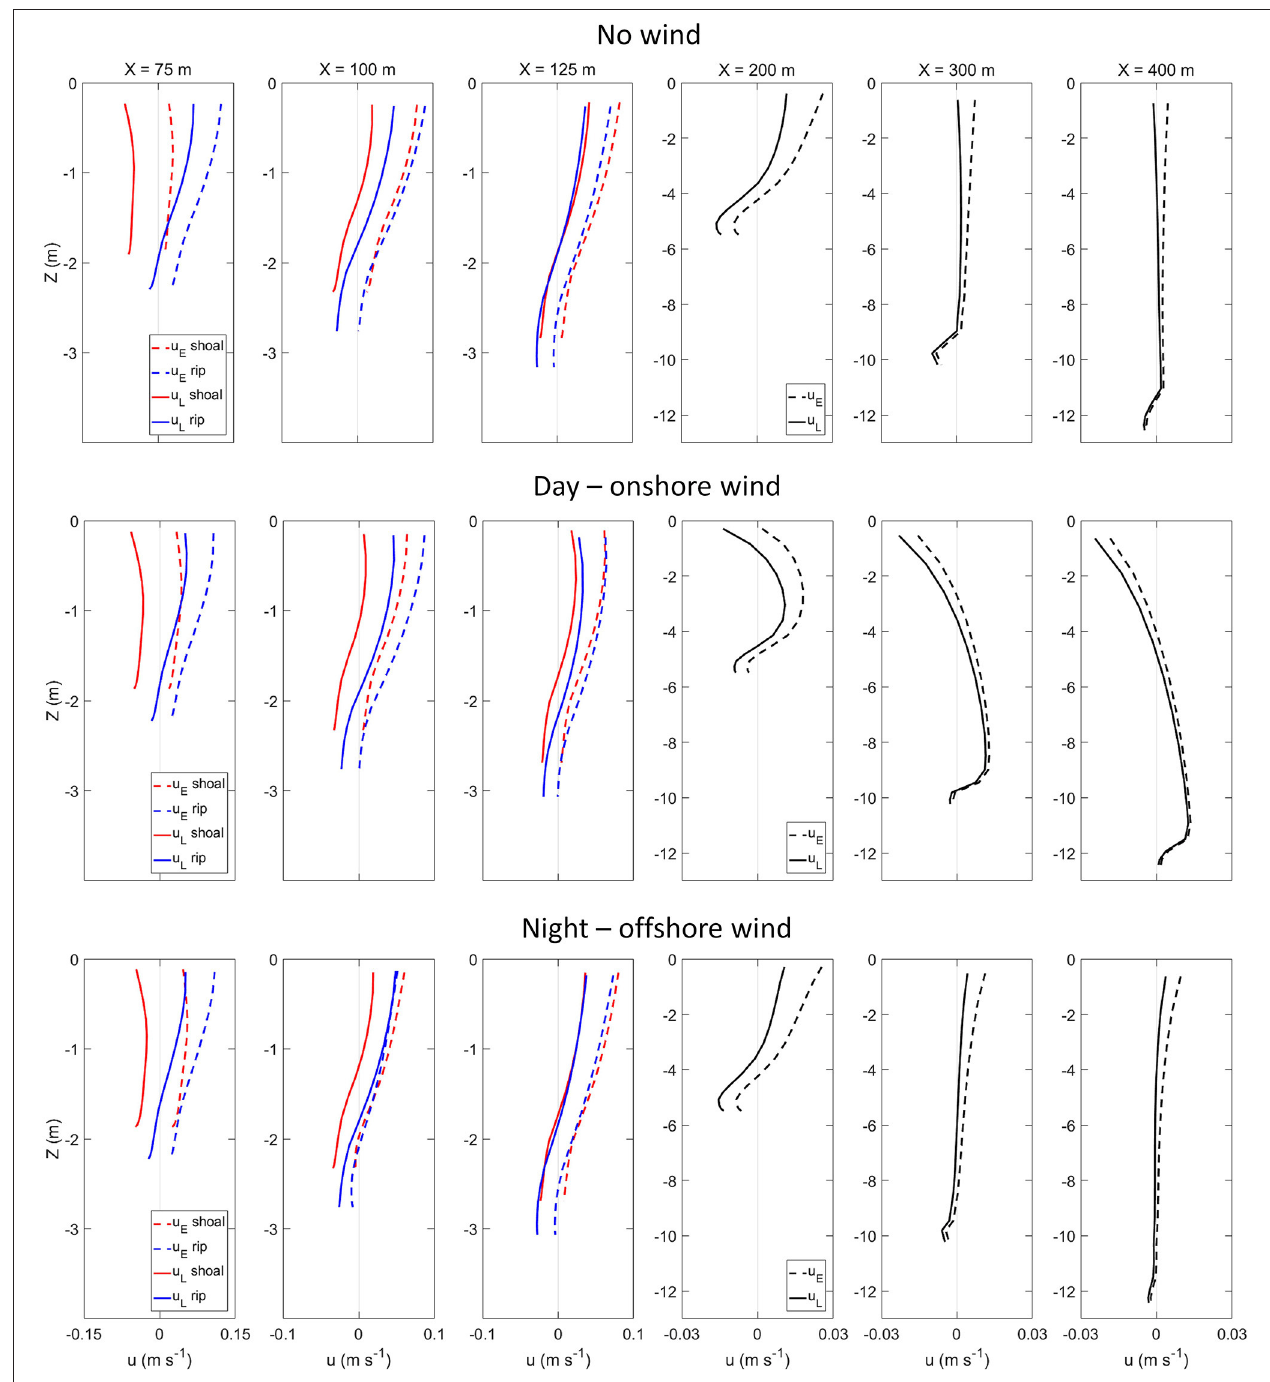
FIGURE 4 | Vertical profiles of alongshore- and time-averaged cross-shore velocities of the hydrodynamic model cases (upper panels) without wind and (middle panels) velocities averaged during the day (24–36h), and (lower panels) night (36–48h) in the diurnal wind cycle. Dashed line is Eulerian velocity ( u E ) and solid line is Lagrangian velocity ( u L ). The first three panels to the left are average velocities in the rip channels (blue) and on the shoals (red), and the others are averages over the total alongshore ranges (black). Positive and negative u values correspond to offshore and onshore currents, respectively. 75m is within the surf zone and 100m is at the breaker